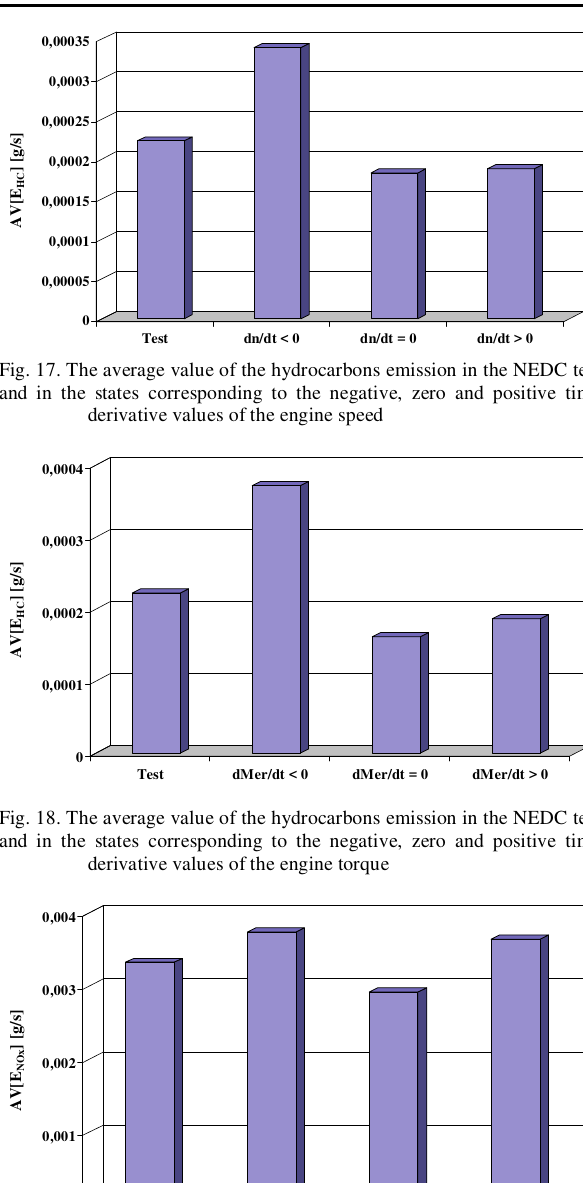
Fig. 15. The average value of the carbon monoxide emission in the NEDC test and in the states corresponding to the negative, zero and positive time derivative values of the engine speed